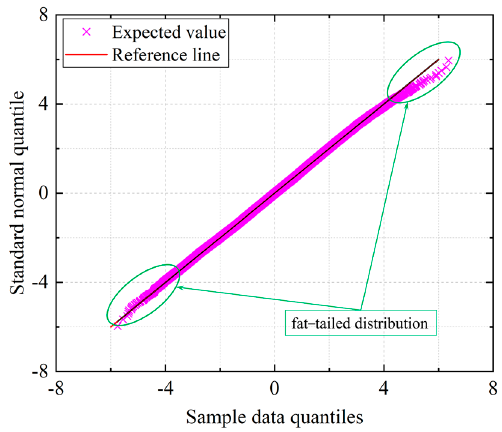
Figure 14. The GPD ‐ fitted Q ‐ Q plot of ploughing